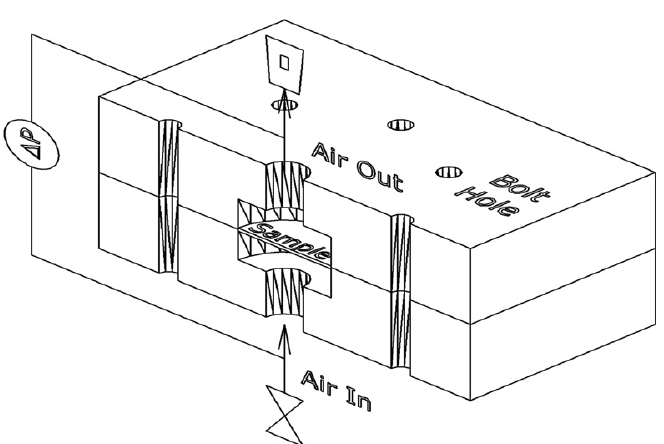
Figure 12. Measurement device for permeability measurements on GDLs. Reprinted from the work in